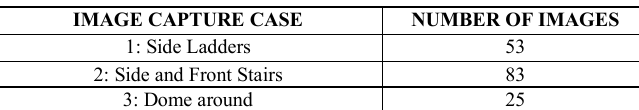
Table 1: Description of the cases to be evaluated according to the